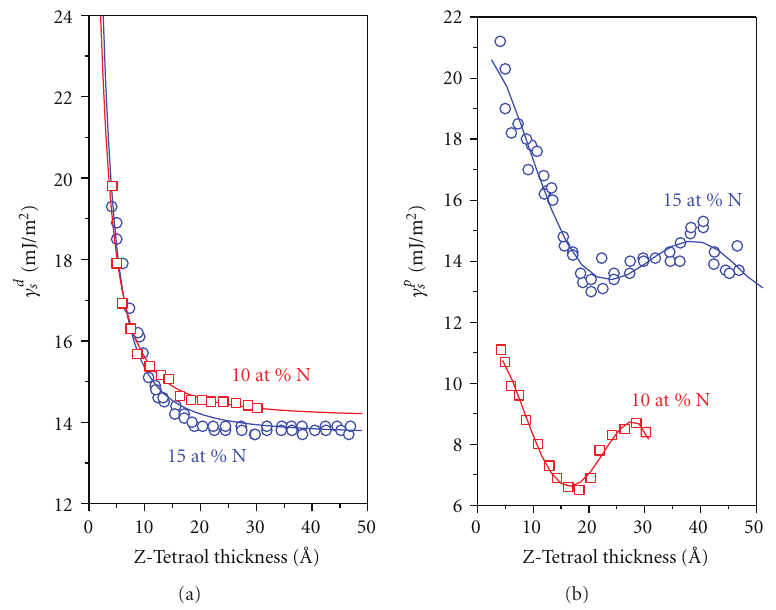
p Figure 6: (a) Dispersive ( γ d s ) and (b) polar ( γ s ) surface energy of Z-Tetraol 2200 as a function of film thickness and carbon film